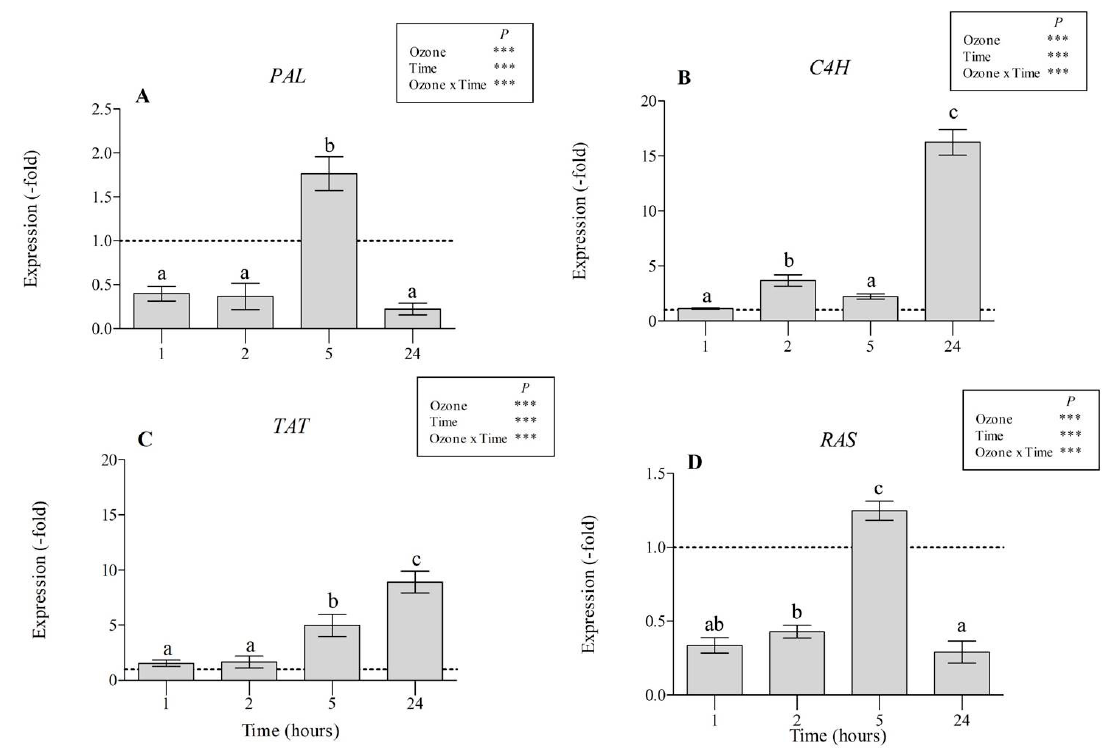
Figure 5. Expression levels of phenylalanine ammonia-lyase (PAL; ( A )), cinnamic acid 4-hydroxylase (C4H; ( B )), tyrosine aminotransferase (TAT; ( C )), and rosmarinic acid synthase (RAS; ( D )) genes in leaves of Salvia officinalis exposed to ozone (120 ppb, 5 h). Gene expression in plants maintained under filtered air (controls) was set to the value 1.0 (dashed line). Data are shown as mean ± standard deviation ( n = 3). Measurements were carried out at 1, 2, 5, and 24 h from the beginning of exposure. Different letters indicate significant differences ( p ≤ 0.05). Boxes show the results of a full factorial two-way ANOVA with ozone and time as variability factors (*** p ≤ 0.001). For each compound ( A – C ), different lowercase letters (a–c) indicate significant differences among means, according to the Tukey’s HSD post-hoc test ( p ≤ 0.05).